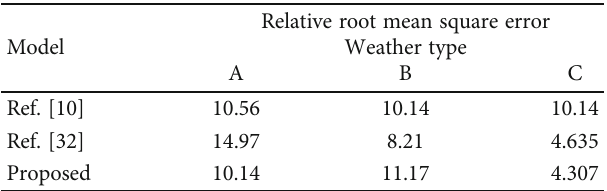
Figure 17: Comparison of power evaluation under di ff erent weather conditions: (a) multisport cloud cluster weather type; (b) low- irradiation type; (c) types of low-movement cloud clusters with high Table 5: Comparison of the accuracy of the proposed and existing algorithms.